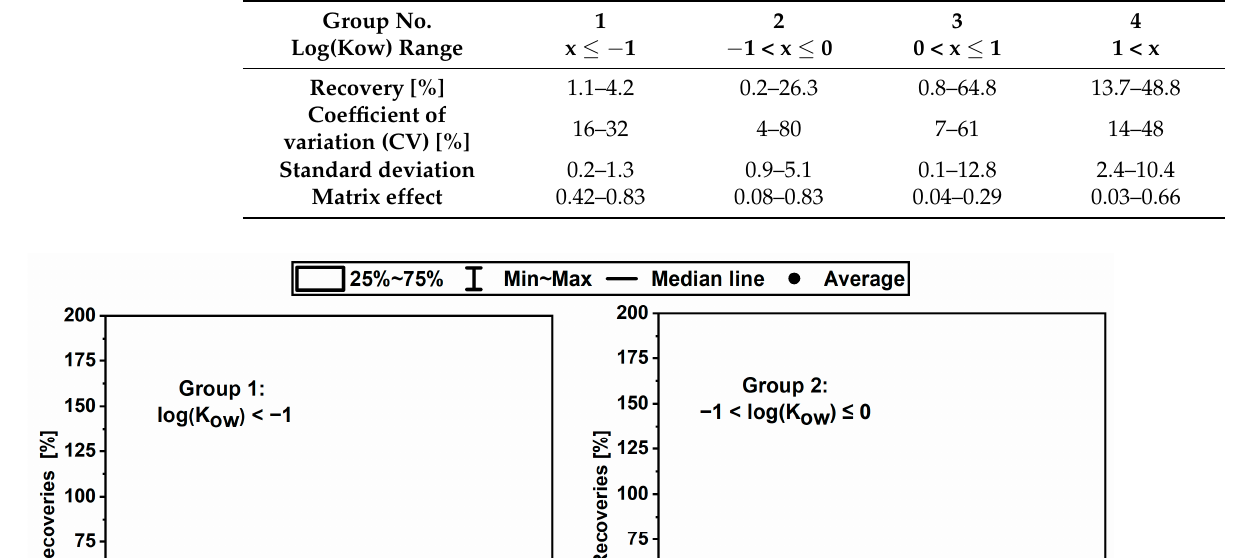
Table 2. An overview of the parameters of the method validation regroup after the log(Kow) groups for 50 and 100 µ g/kg. For each concentration, five replicates were extracted and analyzed. Group No.